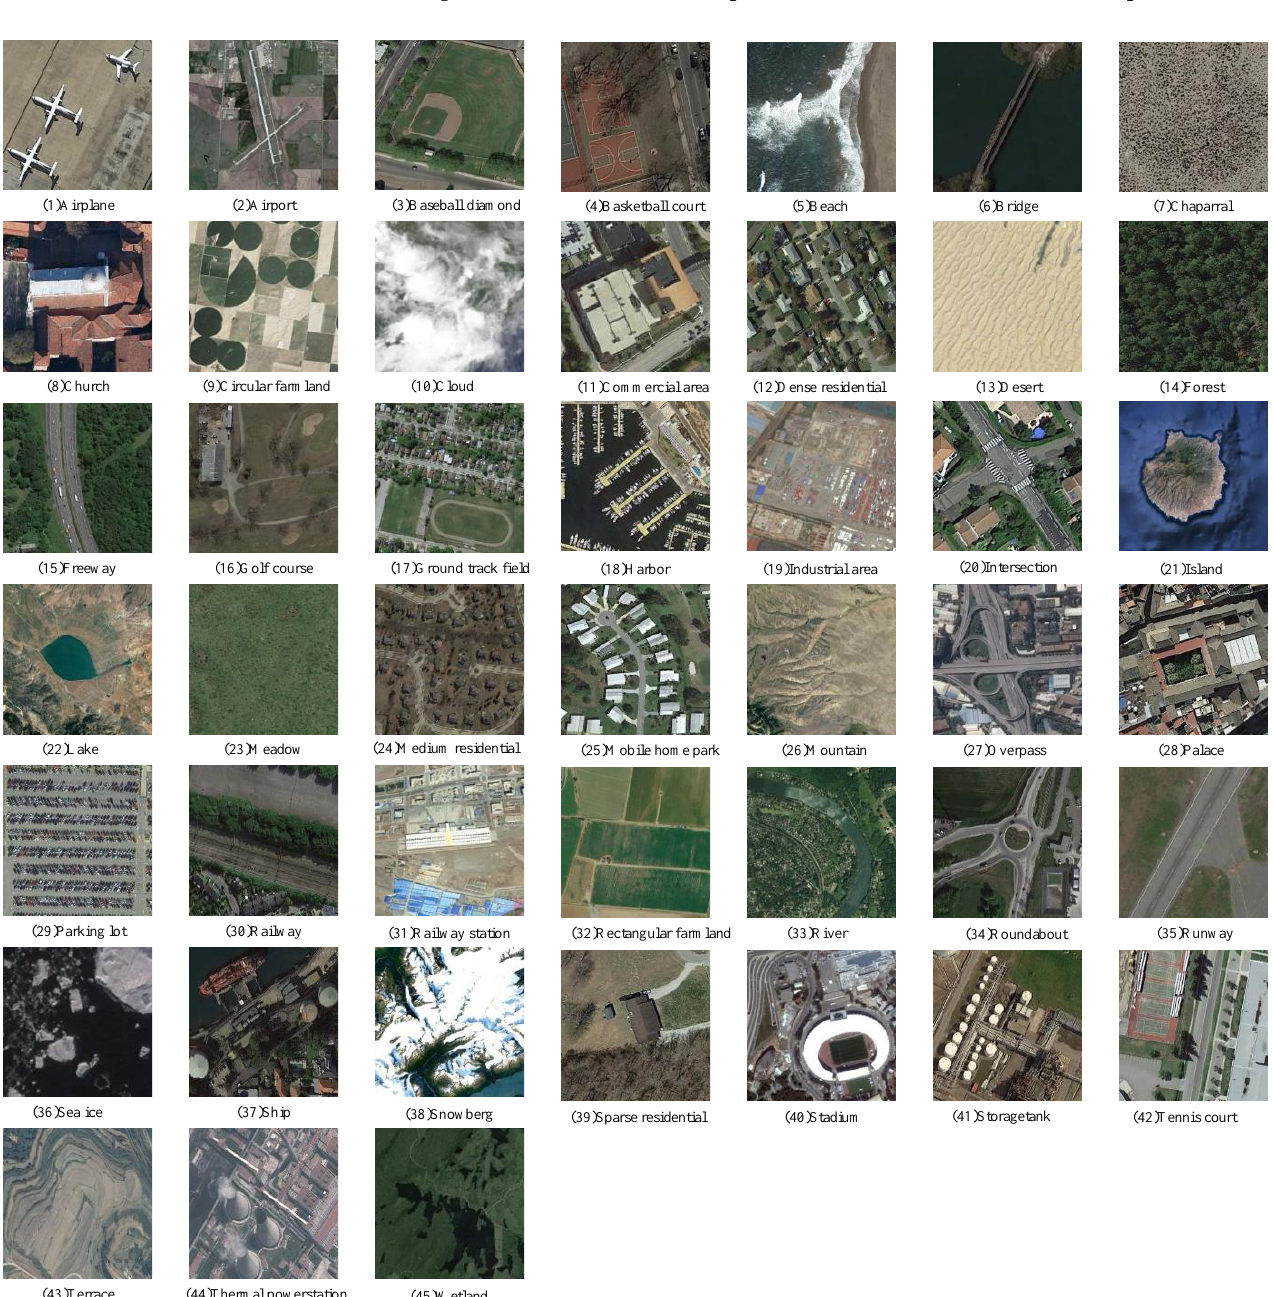
Figure 6. Some samples from the NWPU45 dataset. Table 1. Performance comparison between MobileNet and the proposed method.